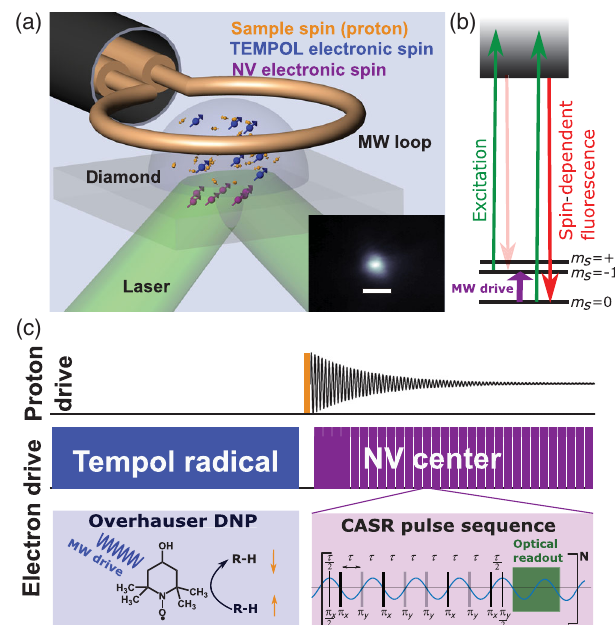
FIG. 1. NV NMR spectroscopy with integrated hyperpolariza- tion. (a) Experimental schematic. Microwave loop antenna near the diamond sensor chip drives both NV (purple) and TEMPOL electronic spins (blue). Hyperpolarized NMR signals from the sample nuclear spins (orange) are detected by NV ensemble fluorescence readout from the diamond chip. Inset: The sensor size is defined by the laser spot size on the diamond (scale bar is 30 μ m). (b) The NV center in diamond exhibits spin-dependent fluorescence with triplet ground-state spin transitions that can be manipulated coherently by resonant microwaves (left top). With a suitable MW pulse sequence [CASR, see bottom right of panel (c)] NMR signals can be detected from microscopic volumes and read-out optically. (c) Integrated hyperpolarized NV NMR spectroscopy pulse sequence. In the first half of the pulse sequence ( ∼ 300 ms), the electronic drive is used to hyperpolarize proton spins in the sample via interactions with electronic spins in the TEMPOL radical using Overhauser dynamic nuclear polari- zation (DNP). In the second half of the pulse sequence ( ∼ 200 ms), a π = 2 pulse on the protons induces a free nuclear precession (FNP) signal from the hyperpolarized sample, which is detected by NV sensor spins via a coherently averaged synchronized readout (CASR) pulse sequence. Bottom left: Overhauser DNP. Continuous microwave driving saturates the electronic spin transition of the TEMPOL radical. Relaxation leads to a net polarization of proton spins in an organic molecule (R-H), which diffuses relative to the TEMPOL radical. Bottom right: The proton FNP signal is detected by the CASR readout scheme, based on interspersed blocks of identical dynamic decoupling sequences synchronized to an external